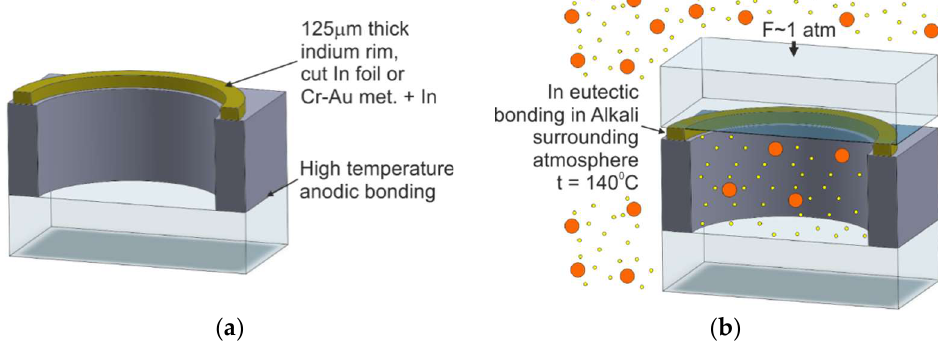
Figure 10. Cell fabrication process utilizing eutectic bonding as the final sealing process: ( a ) silicon–glass preform with Cr–Au met. + In ring, ( b ) cross section of the cell.